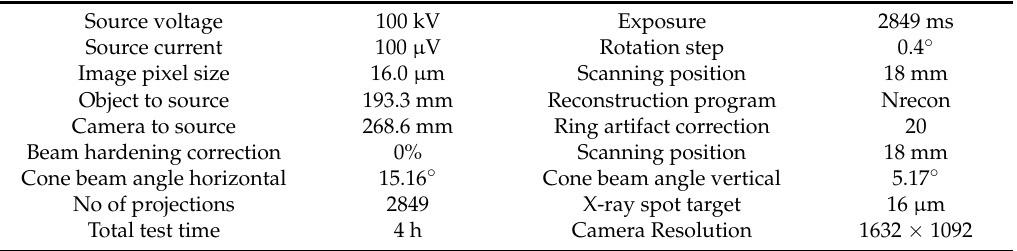
Table 2. Microcomputed tomography ( µ CT) scanning parameters for damage area evaluation (SkyScan 1272, Filter Cu 0.11